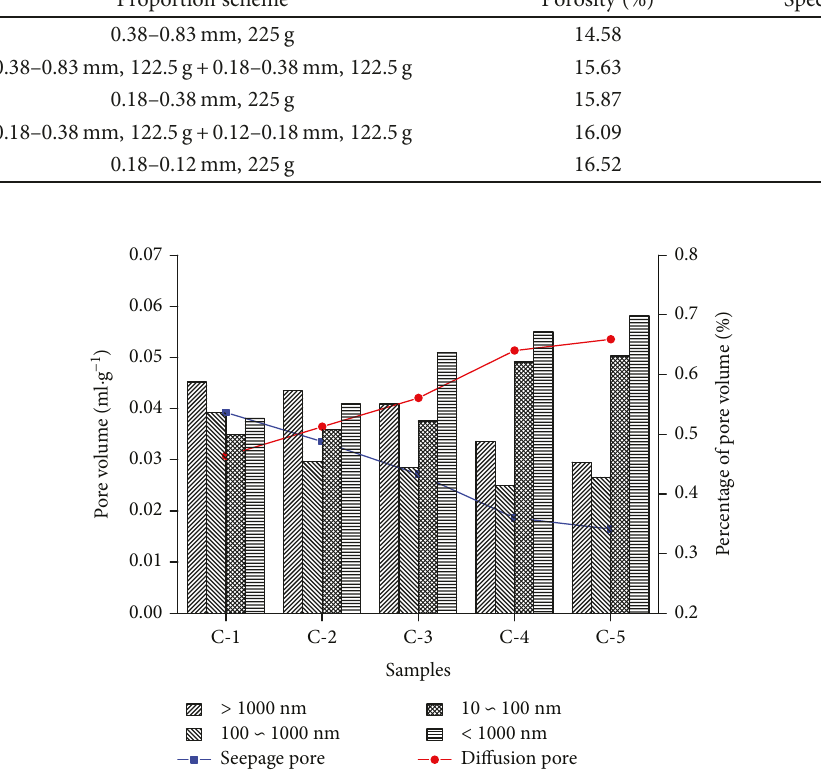
Figure 3: The pore distribution of coal